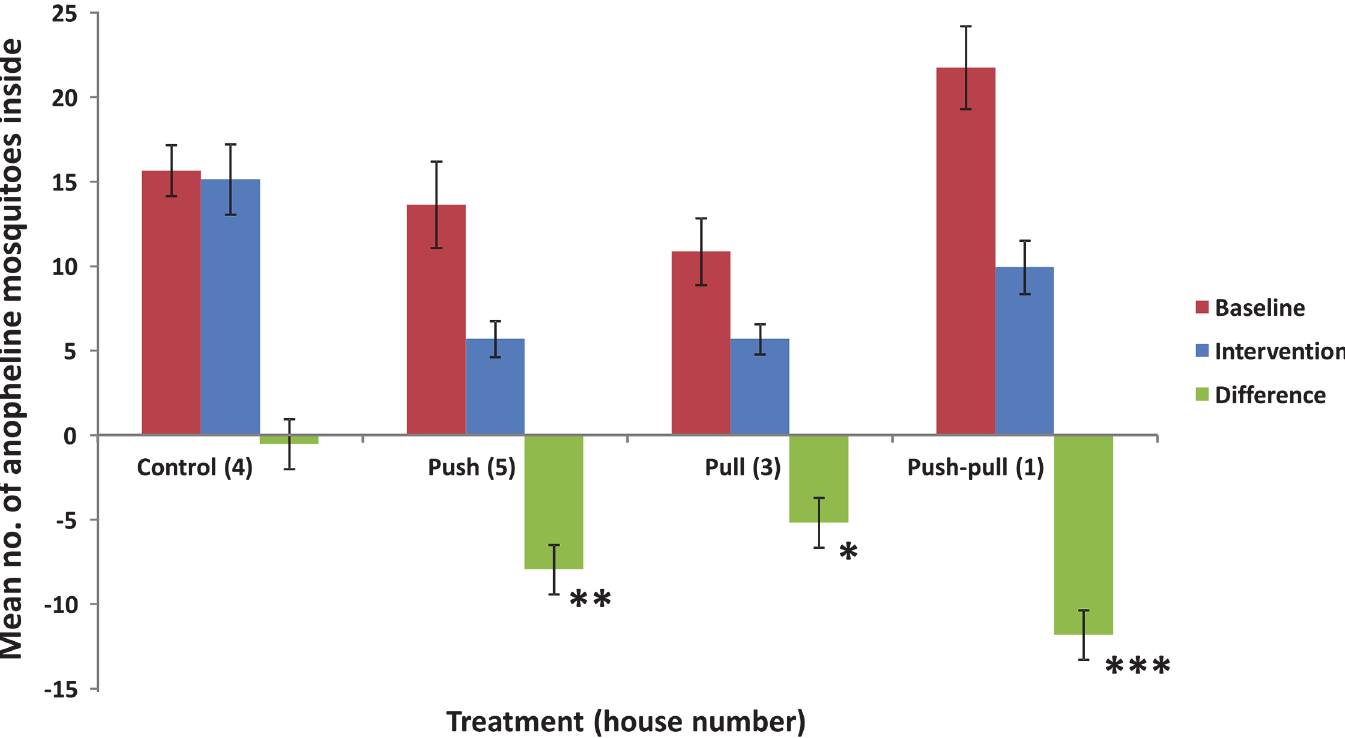
Fig 3. Mean number of anopheline mosquitoes caught inside the houses. Error bars indicate standard error of the mean (SEM), n = 8 for the baseline data (n = 7 for house 3) and n = 25 for the intervention data. Asterisks indicate a significant difference-in-differences between the control and the intervention: * p < 0.05; ** p < 0.01; *** p < 0.001.